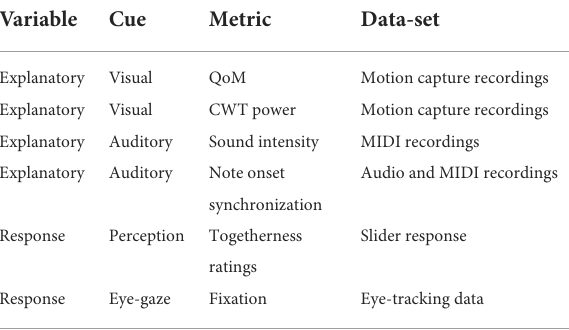
TABLE 2 List of the explanatory and response variables of the study, including the related cues to togetherness, the metrics computed, and the data-set from which they have been